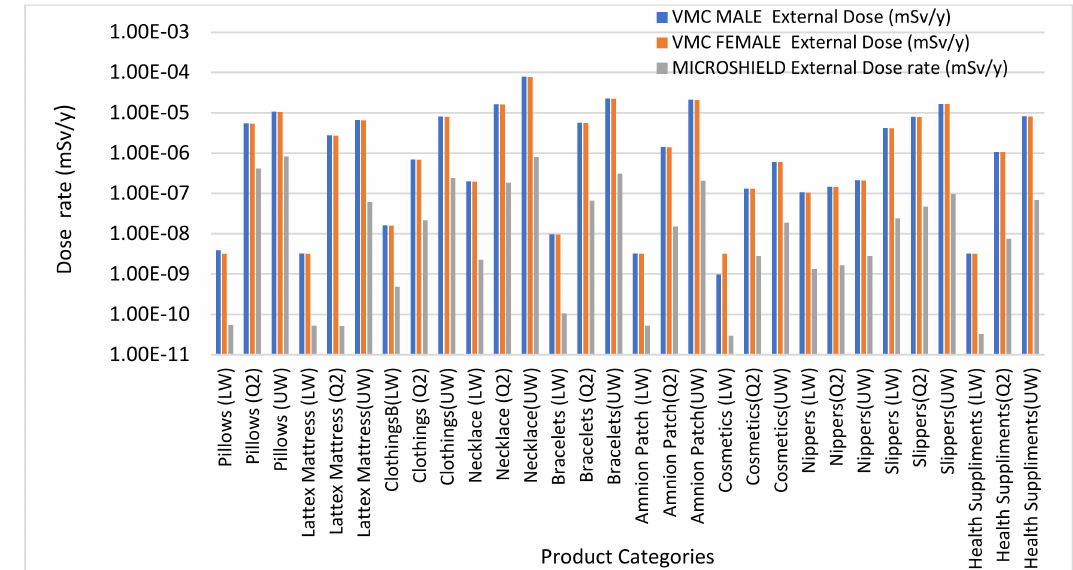
Figure 7. Comparison of external dose using VMC Phantoms and Microshield code.